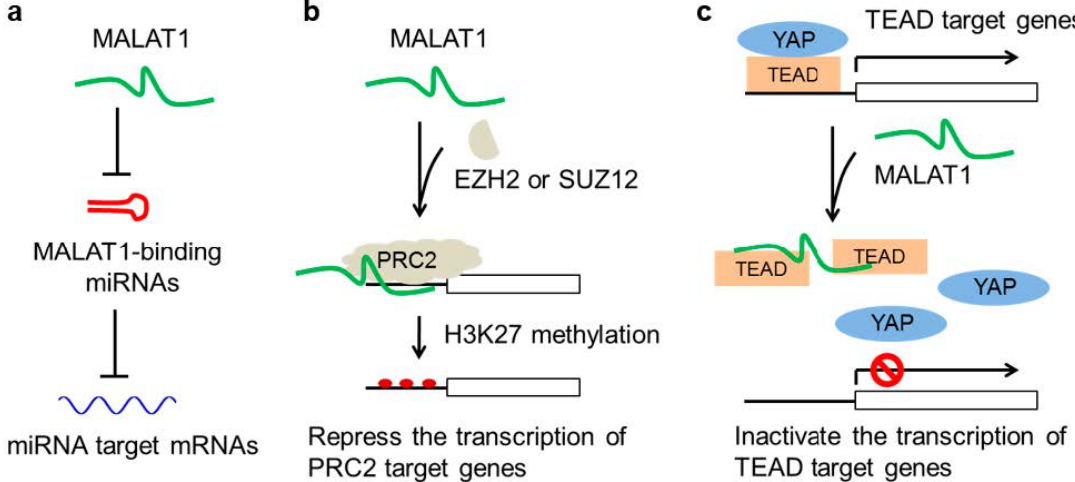
Figure 2. Mechanistic models of MALAT1 in cancer and metastasis. ( a ) MALAT1 sponges miRNAs, leading to repression of miRNA target mRNAs. ( b ) MALAT1 binds PRC2 components and recruits PRC2 to target gene loci. ( c ) MALAT1 binds, sequesters, and inactivates TEAD.